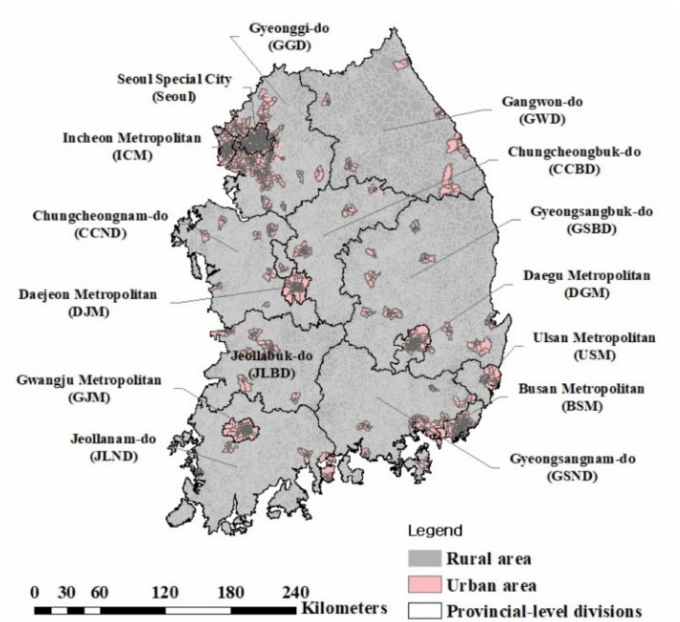
Figure 1. Location of provincial-level divisions in South Korea except for Jeju island. South Korea consists of 17 first-tier administrative divisions: 6 metropolitan cities, 1 special city, 1 special self-governing city, and 9 provinces. The gray and pink areas indicate rural and urban areas, organized sub-municipal level divisions (Dong (neighborhood in Urban) and Ri (Village in